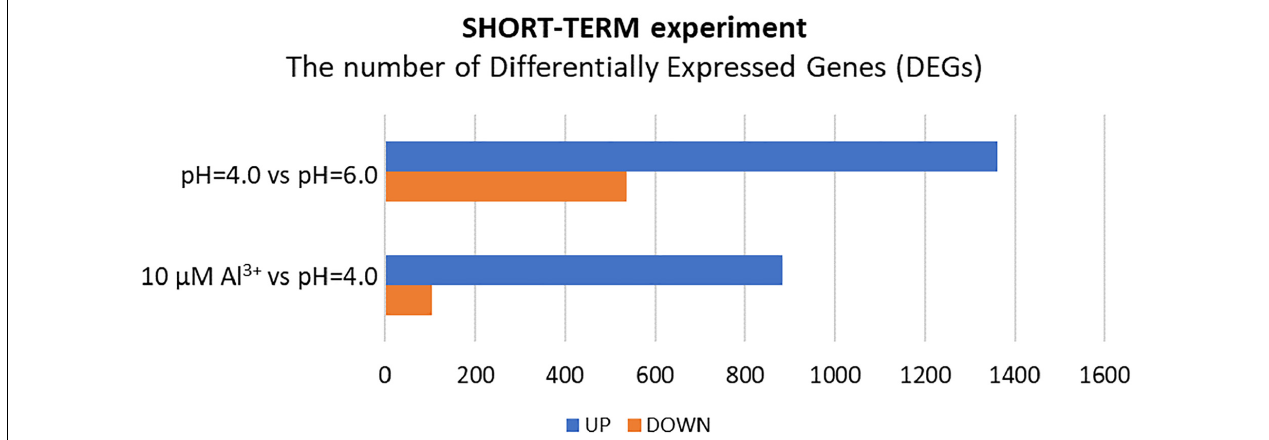
FIGURE 5 | The number of differentially expressed genes (DEGs) in the transcriptome of barley root meristems in the short-term experiment. DEGs were determined for plants grown at pH = 4.0 compared to pH = 6.0; and after 24 h treatment with 10 µ M Al at pH = 4.0 compared to pH = 4.0 without Al 3 + ions (DEGs were identified under α = 0.05 with FDR adjusted P -value and log 2 FC ≥ 1 or ≤ –1).